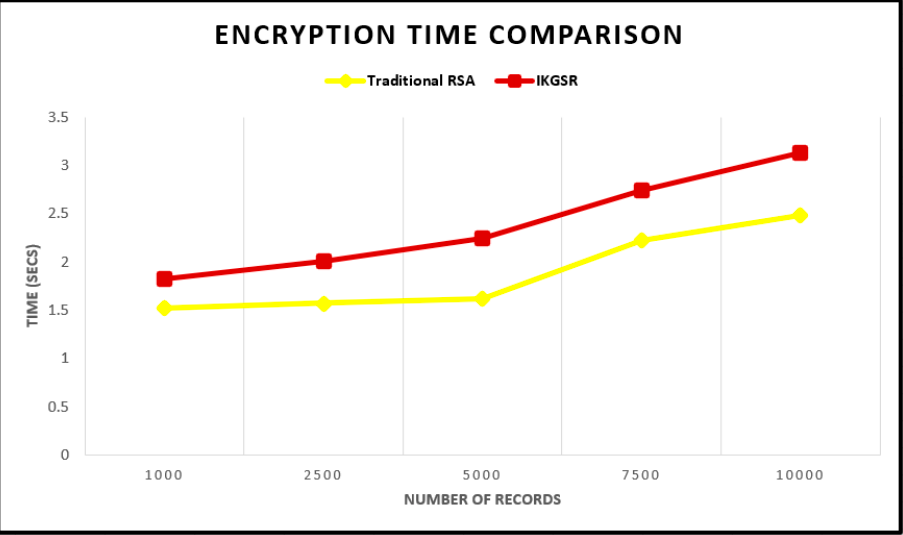
Figure 10. Encryption Time Comparison against Traditional RSA.